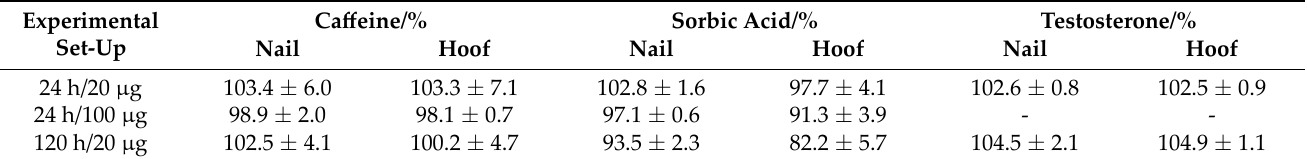
Table 1. Recovery of caffeine, sorbic acid, and testosterone at the end of the drug uptake studies. Experimental set-up: test period and applied active ingredient. Mean value ± standard deviation, n = 6.